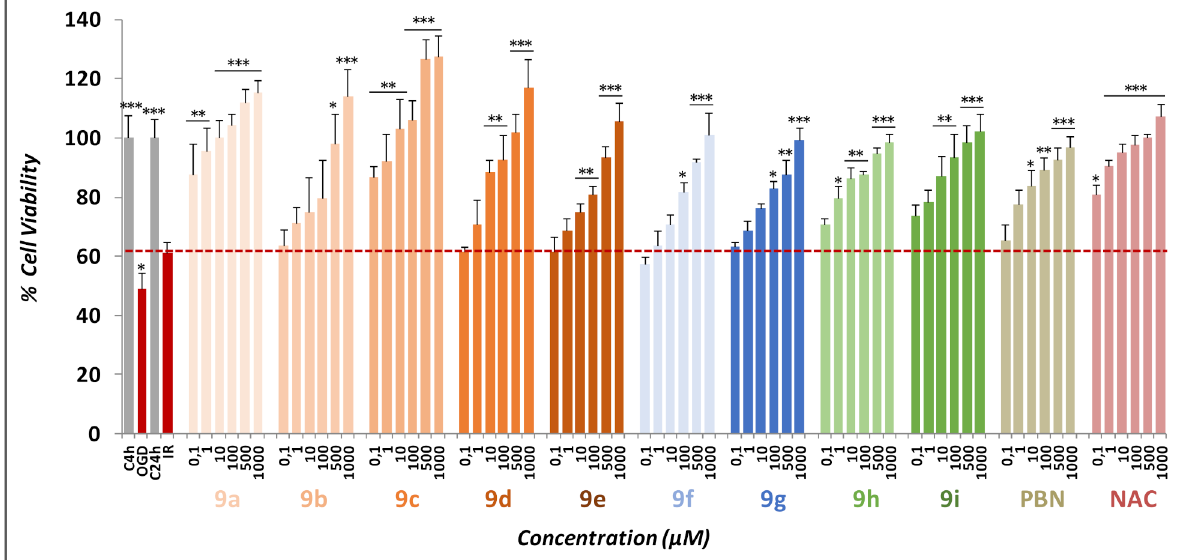
Figure 3. Neuroprotective effect of nitrones 9a – i , α -phenyl-N-tert-butylnitrone ( PBN ), and N-acetyl- L-cysteine ( NAC ) on SH-SY5Y human neuroblastoma metabolic activity after OGD treatment (4 h) followed by OGR (24 h) (IR). Bars show percent cell viability at the indicated concentrations of nitrones 9a – i , PBN , and NAC . Values represent the mean ± SEM of three experiments, each one performed in triplicate. The statistics compare the differences with IR condition alone (red dotted line) at * p < 0.05, ** p < 0.01, and *** p < 0.001 (one-way ANOVA, followed by Holm − Sidak analysis as a test post